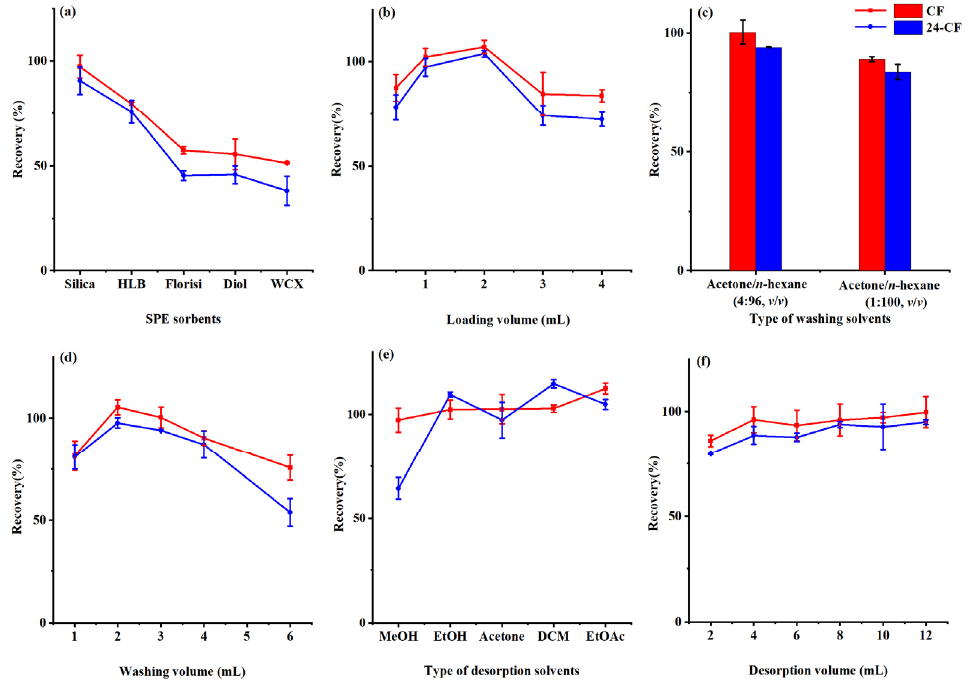
Figure 1. Optimization of SPE conditions for SPE sorbents ( a ), loading volume ( b ), type of washing solvents ( c ), washing volume ( d ), type of desorption solvents ( e ) and desorption volume ( f ).